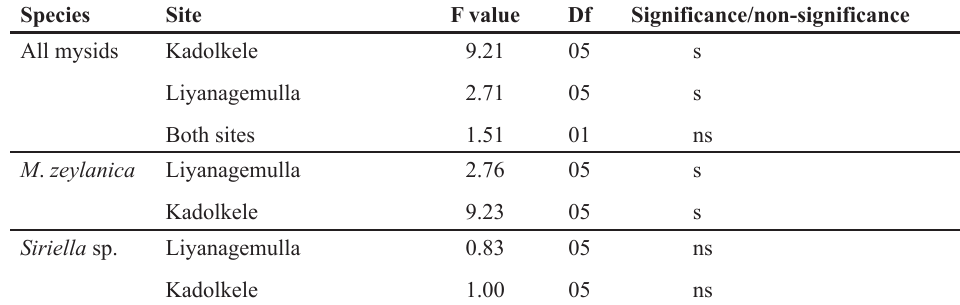
Table 4: Synopsis of significance/non-significance in variation of mysid numbers among months and between sites.